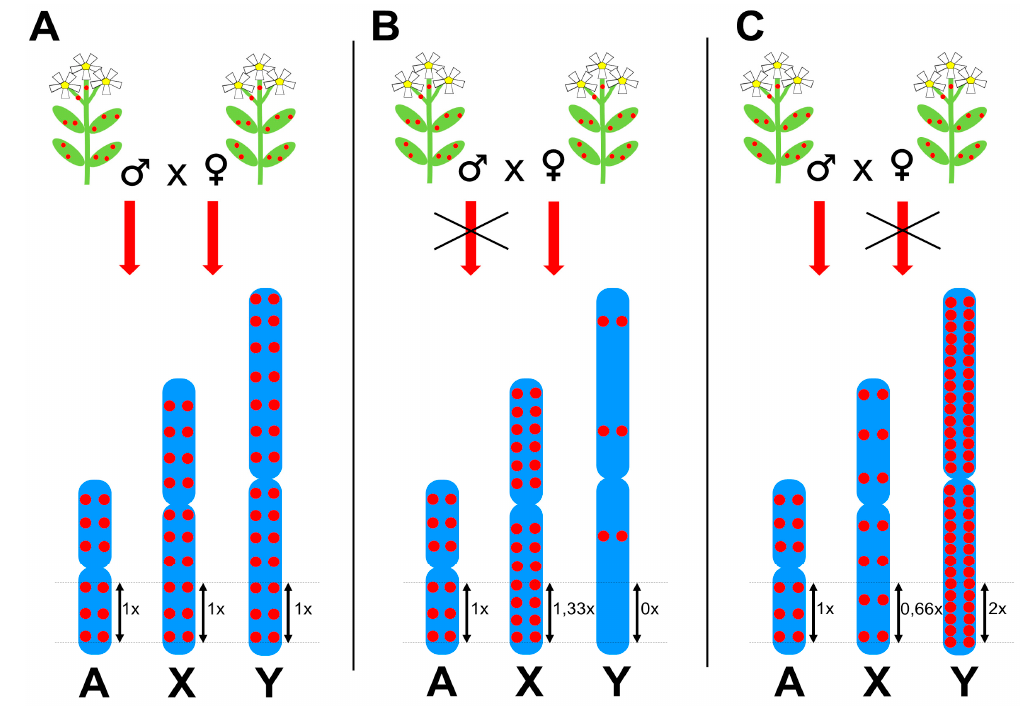
Figure 3. Three scenarios of transgenerational proliferation of transposable elements (TEs) in plants and their impact on the chromosomal distribution of a TE. Red dots indicate TE insertions—in blue-colored meiotic chromosomes, A-autosomes, X-chromosomes, and Y-chromosomes. Numbers next to double arrows indicate the expected density of TE insertions per one unit of length of a respective chromosome. ( A ) If a TE is passed down to offspring equally in males and females, TE insertion density is identical on all chromosomes. ( B ) If TE proliferation is disrupted in males, TE density is 1,33 times higher on the X chromosome than on autosomes, but nearly zero on the Y chromosome. ( C ) If TE proliferation is disrupted in females, TE insertion density is lower on the X chromosome compared to autosomes and twice as high on the Y chromosome than on autosomes. These three scenarios represent extreme cases of sex-specific TE activity. Real world TEs range from TEs that are almost fully sex-specifically inheritable to TEs with only slight sex-dependent inheritance.